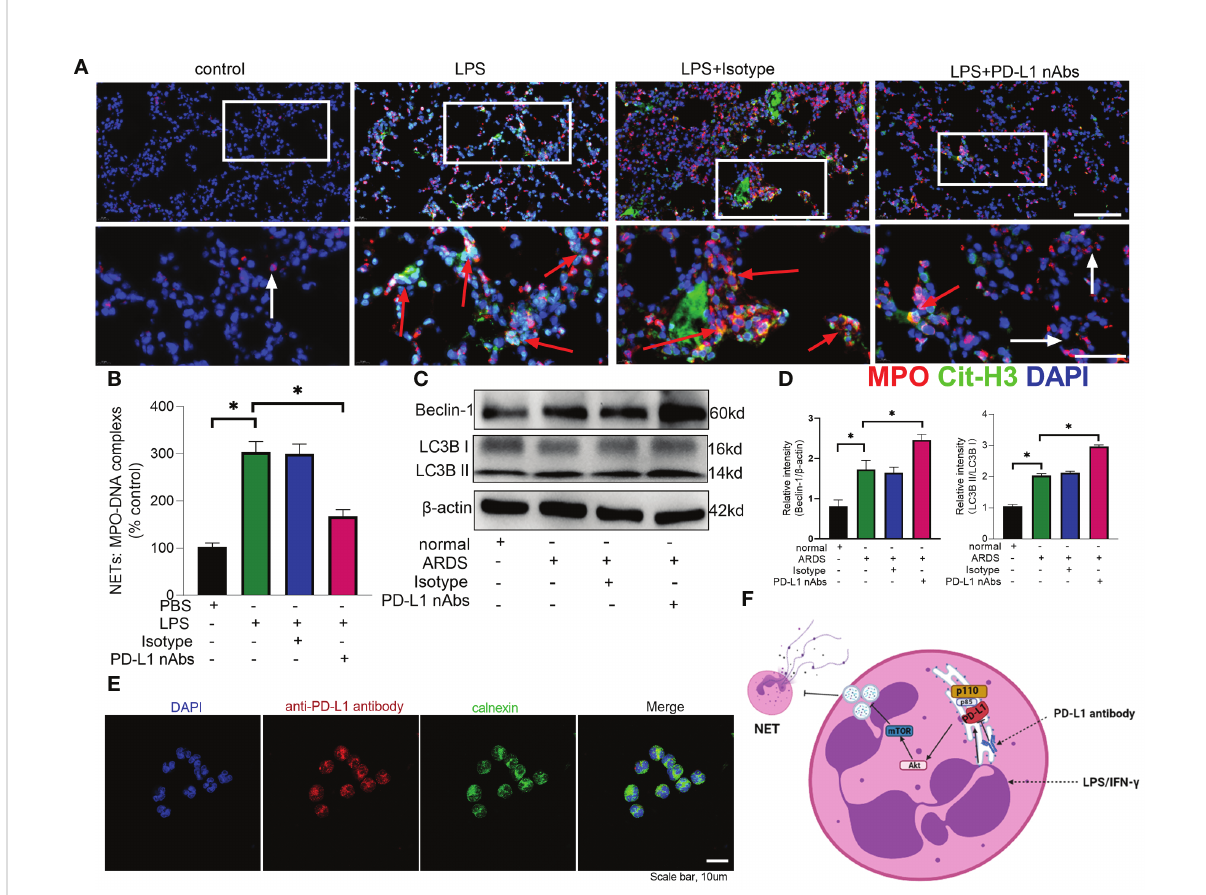
FIGURE 8 Anti-PD-L1 antibody can reduce NET release and increase autophagy levels in neutrophils via the PD-L1-PI3K/Akt/mTOR-autophagy-NETs pathway. (A, B) C57BL/6 mice injected intratracheally with LPS (10mg/kg) were treated with anti-PD-L1 antibody (50ug/mouse) or Isotype antibody for 24h. (A) Representative immuno fl uorescence images of Cit H3 (green) and MPO (red) staining with blue DAPI nuclear staining in lungs. Neutrophils express MPO (red) and NETs forming neutrophils also express Cit-H3 (green). Cyan fl uorescence represents the colocalization of Cit-H3 with DNA. The white arrowheads point to neutrophils not making NETs and the red arrows to neutrophils making NETs. The scale bar indicates 20 m m. Higher magni fi cation images are shown lower row of fi gures – scale bars indicate 10 m m. (B) MPO-DNA complex measured in NETs structures in BALF. (C) Neutrophils from ARDS patients were treated with anti-PD-L1 antibody (10ug/106 cells) for 21h, Beclin-1 and LC3B II/I immunoblotting in neutrophils. (D) Integrated optical density ratio of LC3B II/LC3B (I) (E) Neutrophils from ARDS patients were treated with anti-PD-L1 antibody (10ug/106 cells) for 24h, which were located on the ER (confocal microscopy; blue: DNA; red: PD-L1 antibody; green: calnexin (ER marker)) (scale bar: 10um). (F) When neutrophils receive LPS/IFN- g stimulation, PD-L1 expression is elevated and binds to PI3K regulatory subunit p85 at the ER. Phosphorylated p85 binds tightly to catalytic subunit p110 to phosphorylate downstream Akt/mTOR. mTOR upregulation inhibits autophagy, which leads to the release of excessive NETs from the neutrophils. PD-L1 antibody enters the neutrophils at the ER to inhibit PD-L1 catalysis downstream of PI3K. The values presented are mean ± SEM (n=6; *P<0.05, one-way analysis of